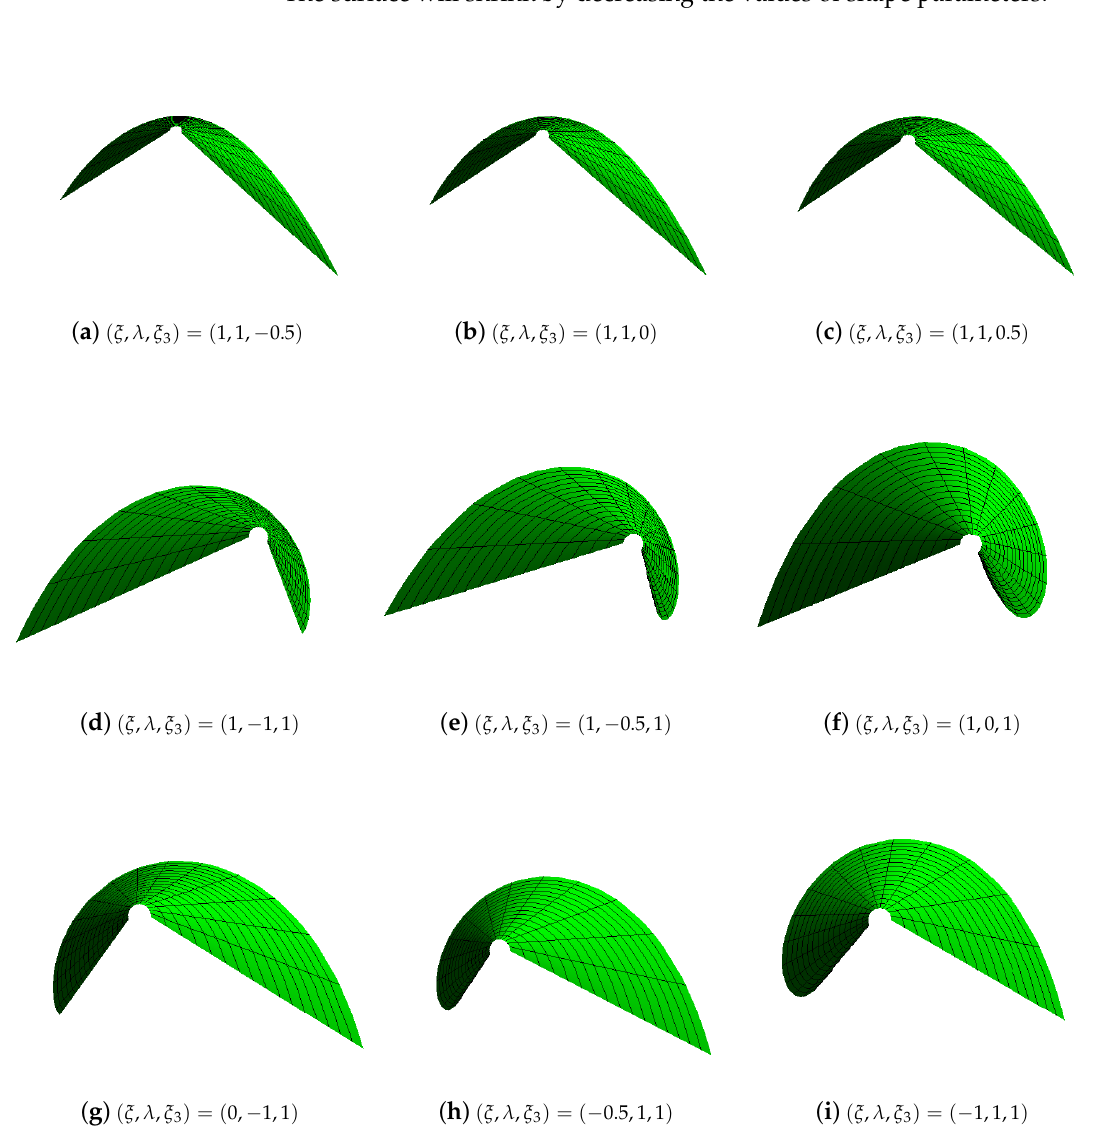
Figure 4. Enveloping developable GHT-Bézier surfaces, having different values of ξ , λ , ξ 3